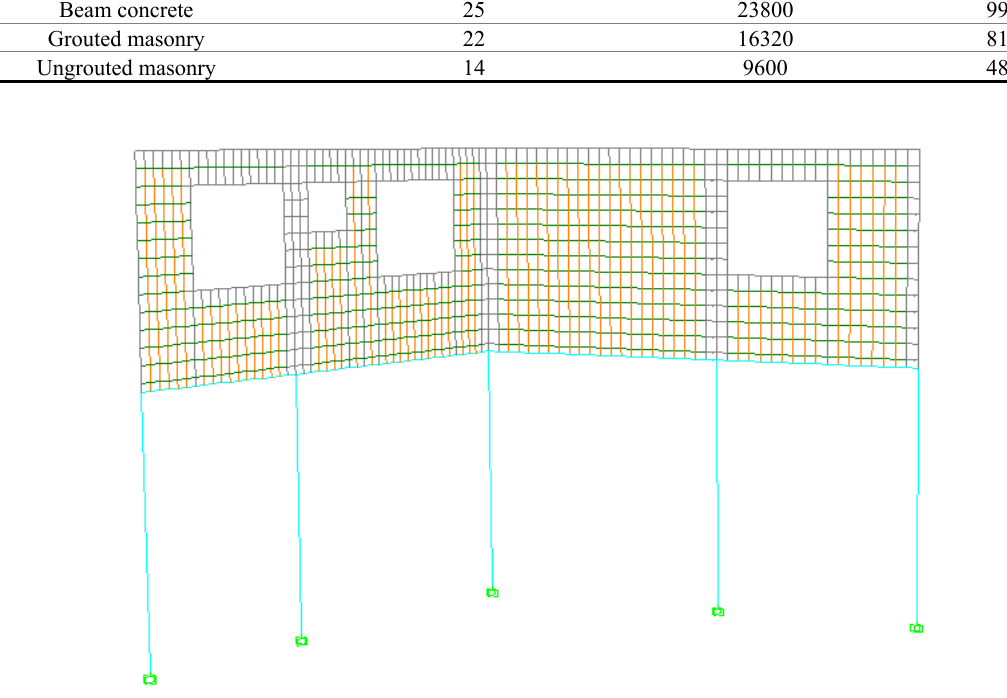
Figure 3. W30 and W1 discretization in the three-dimensional